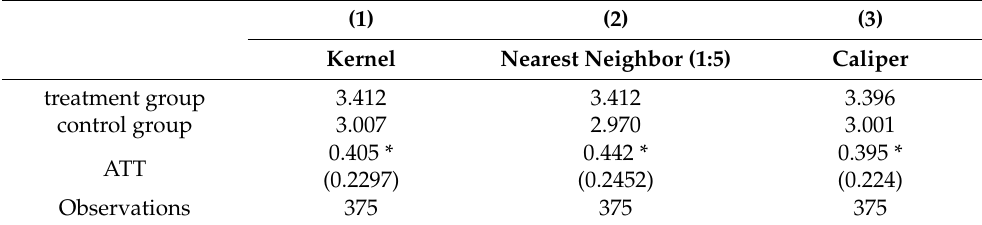
Table 6. Impact of Training on farmers’ willingness to adopt straw returning: PSM method.